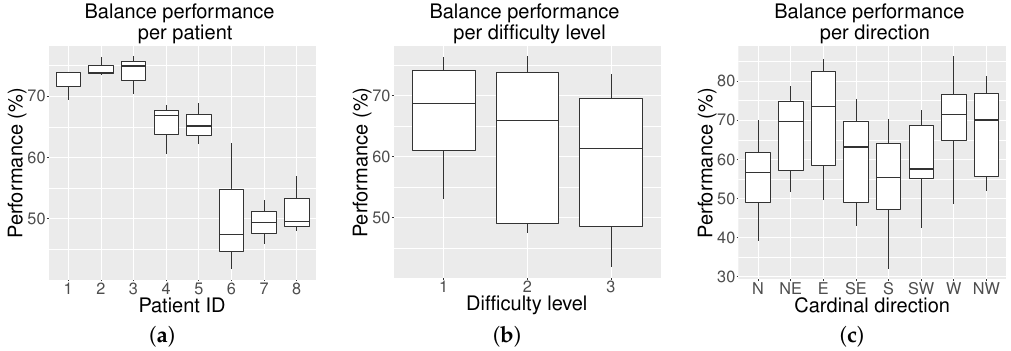
Figure 5. Average balance results (%) on the hemophilic population for all eight cardinal and intermediate positions: ( a ) box plot of average balance performance per patient including all three levels; ( b ) box plot of average balance performance per level for all patients; and ( c ) box plot of the average balance performance per cardinal direction for all patients and